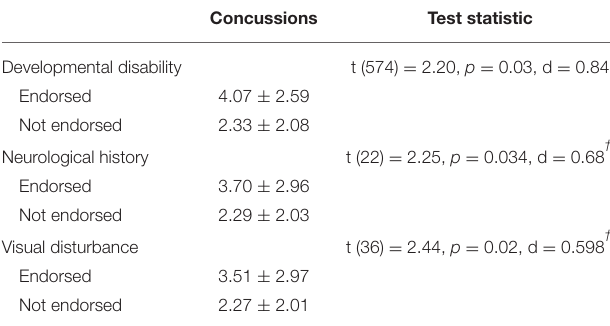
TABLE 3 | Concussions by demographic and medical history